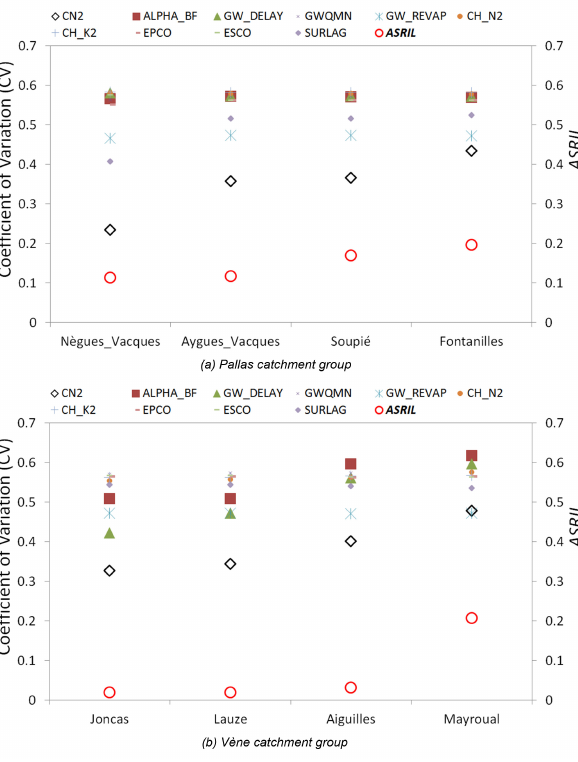
Figure 8. Relationship between the CV variability of the transferred model parameter from gauged to the ungauged catchments and the ASRIL factor within each catchment group.